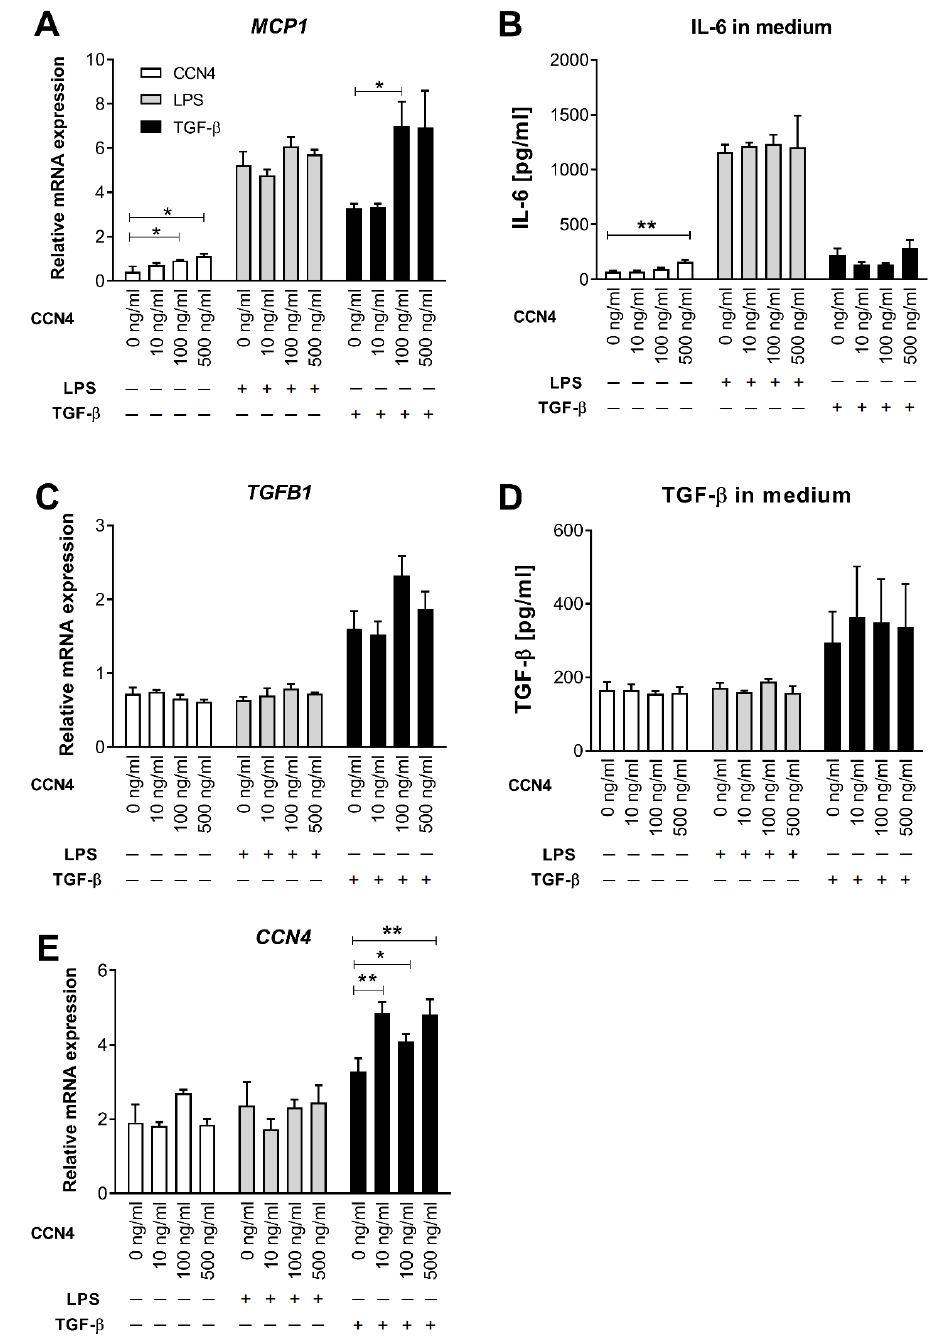
Figure 3. CCN4 effects on inflammatory markers in hepatic stellate LX-2 cells. LX-2 cells were stimulated for 24 h with human recombinant CCN4 (0, 10, 100 or 500 ng/mL; in white) alone or in combination with 1 ng/mL LPS (grey bars) or 1 ng/mL TGF- β (black bars) ( n = 4). ( A , C , E ) Gene expression was measured by qPCR. ( B , D ) Cytokine secretion was determined by multiplex assay. Data are shown as mean ± SEM. * p < 0.05, ** p < 0.01.